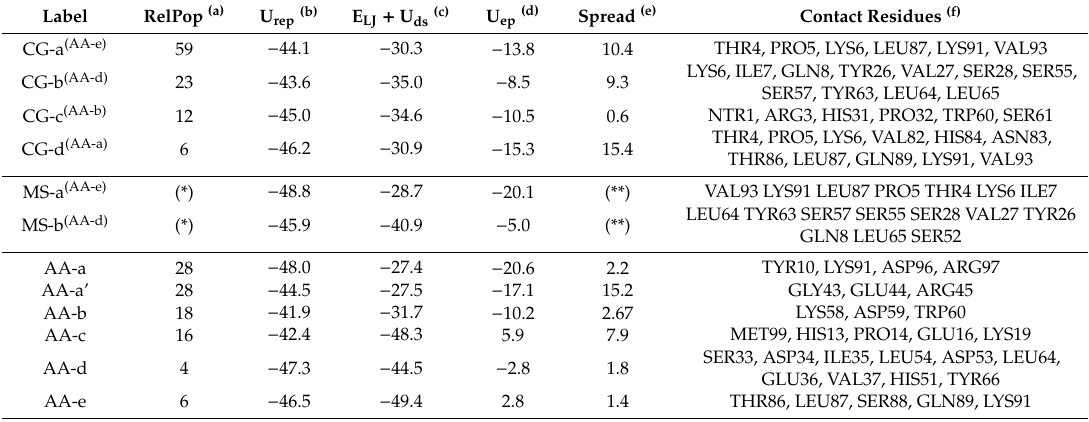
(a) Relative population of this cluster (b) U rep : total interaction energy of the representative of the given cluster in kT with T = 300 K, (c) E LJ : Lennard-Jones energy term for the representative complex, U ds : non-polar (hydrophobic) desolvation energy of the representative complex, in kT, (d) U ep : total electrostatic energy of the representative complex, in kT, (e) Spread: (Root Mean Square Deviation) of the structures within the cluster with respect to the representative complex, Å, (f) Contact Residues: Residues at 5.5 Å distance (CG and MS) and at 3.5 Å distance (AA) from the NPs in the final most representative patch, (*) See binding energy maps in Figure 2 for RelPop (**) not available for mesoscale calculation.